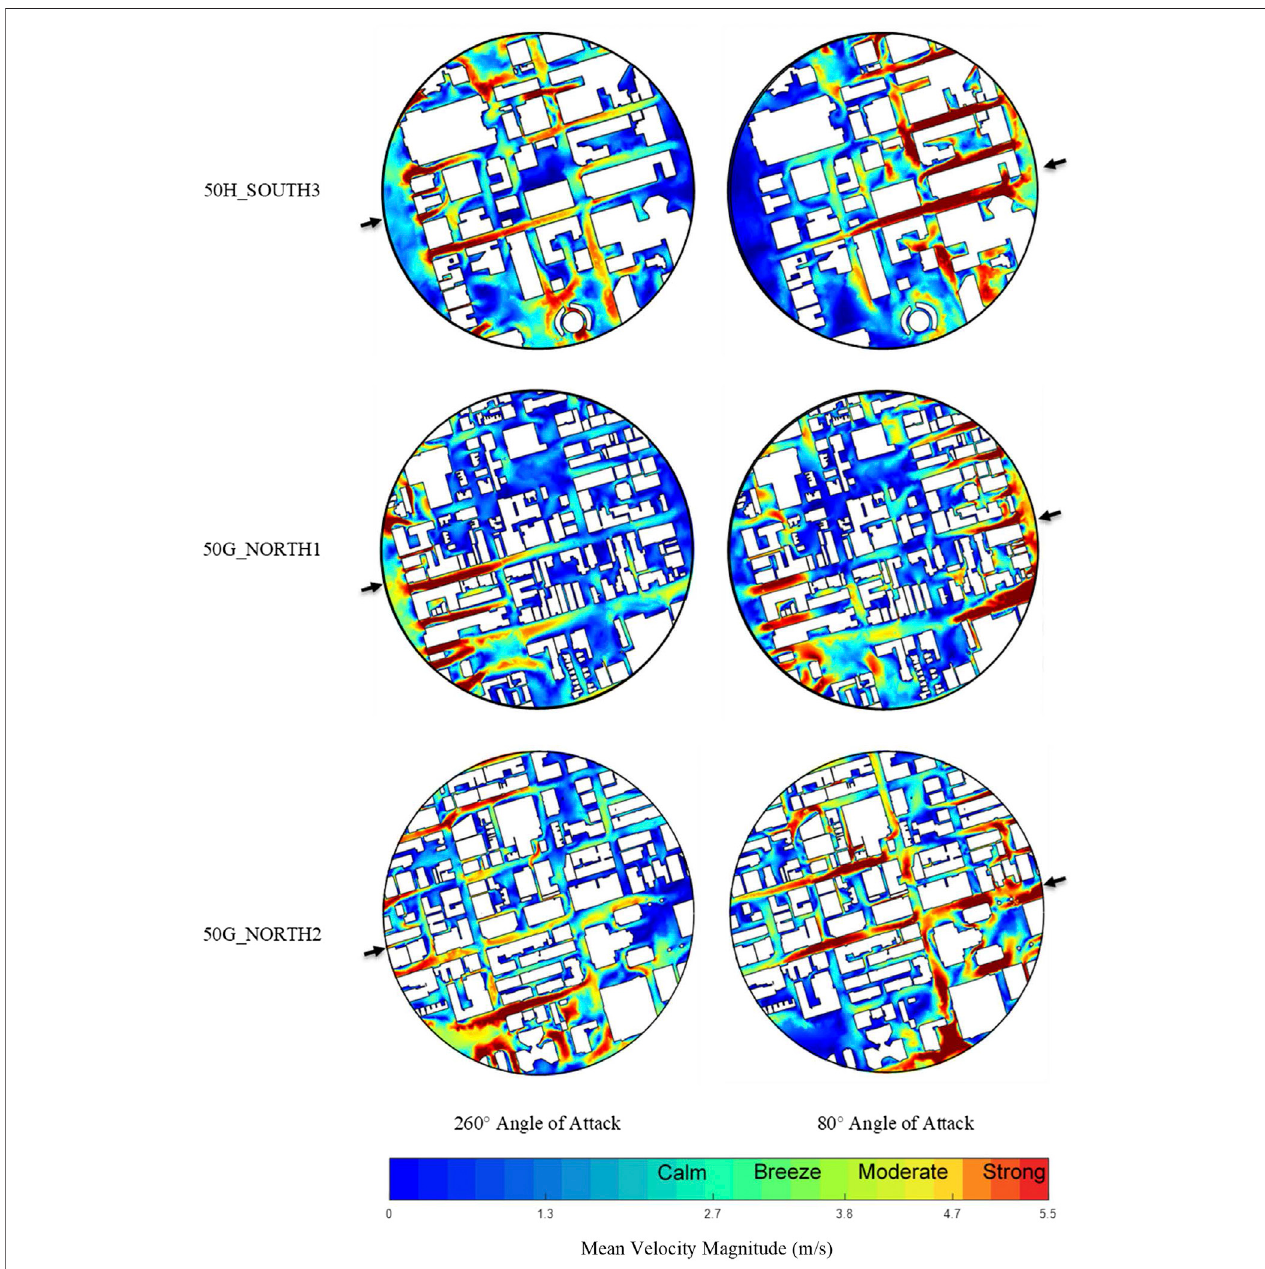
FIGURE 11 | PLW Velocity Contours for real-time